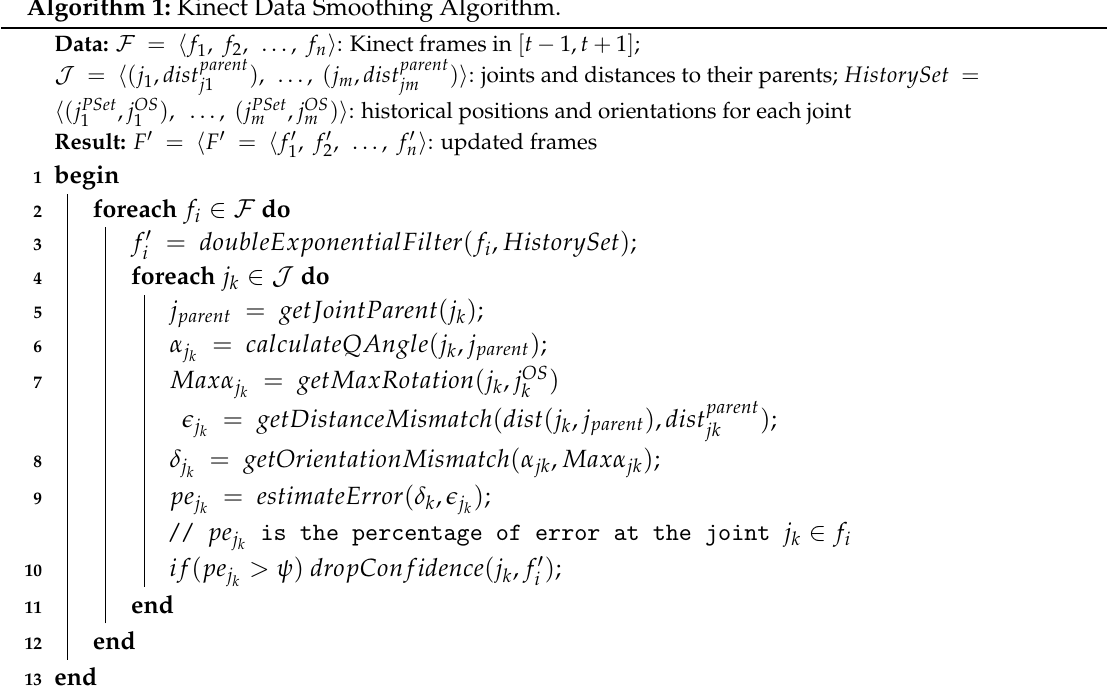
Algorithm 1: Kinect Data Smoothing